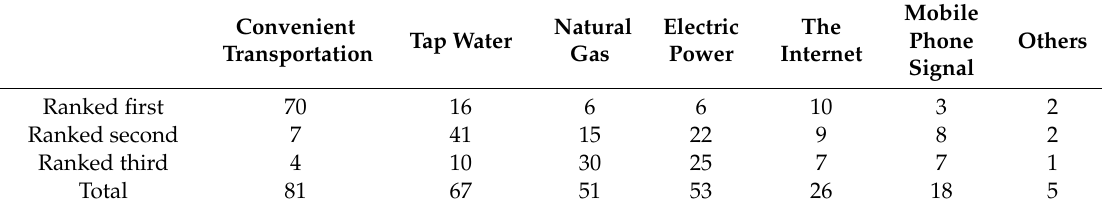
Table 5. The most important conditions expected by urban